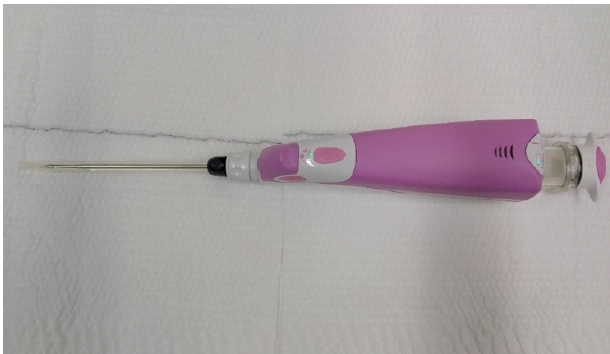
Figure 1. Vacuum ‐ assisted breast biopsy (VABB) Elite ultrasound ‐ guided biopsy handpiece, manageable and slightly larger than a core biopsy (CB) handpiece.